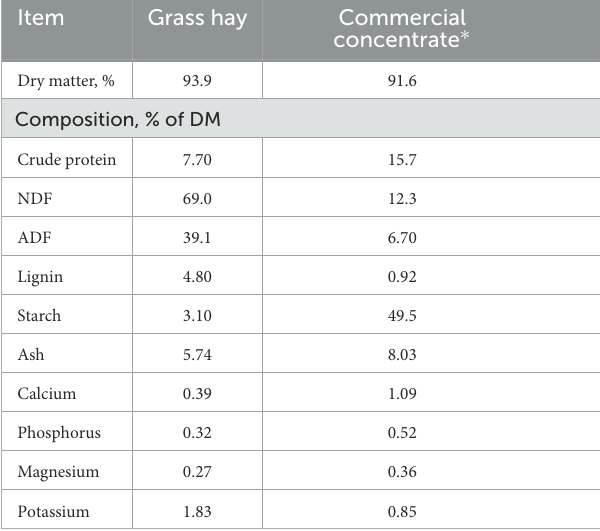
TABLE 3 Chemical composition of grass hay and commercial concentrate fed to lambs during the